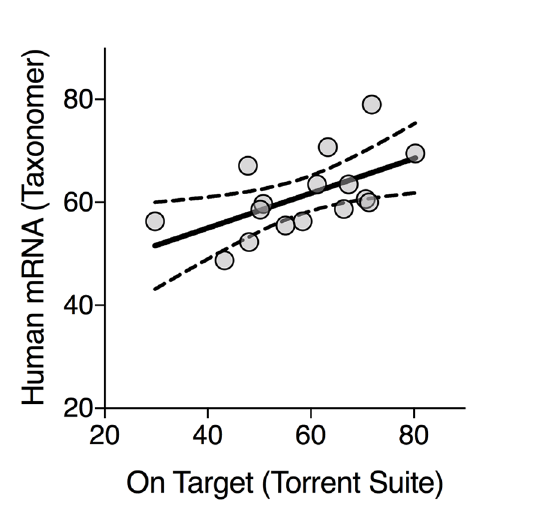
Supplementary Figure 2. Correlation of sample composition and expression profiling by Tax- onomer (y-axis, percentage of human mRNA reads) and Torrent Suite (x-axis, percentage reads on target).